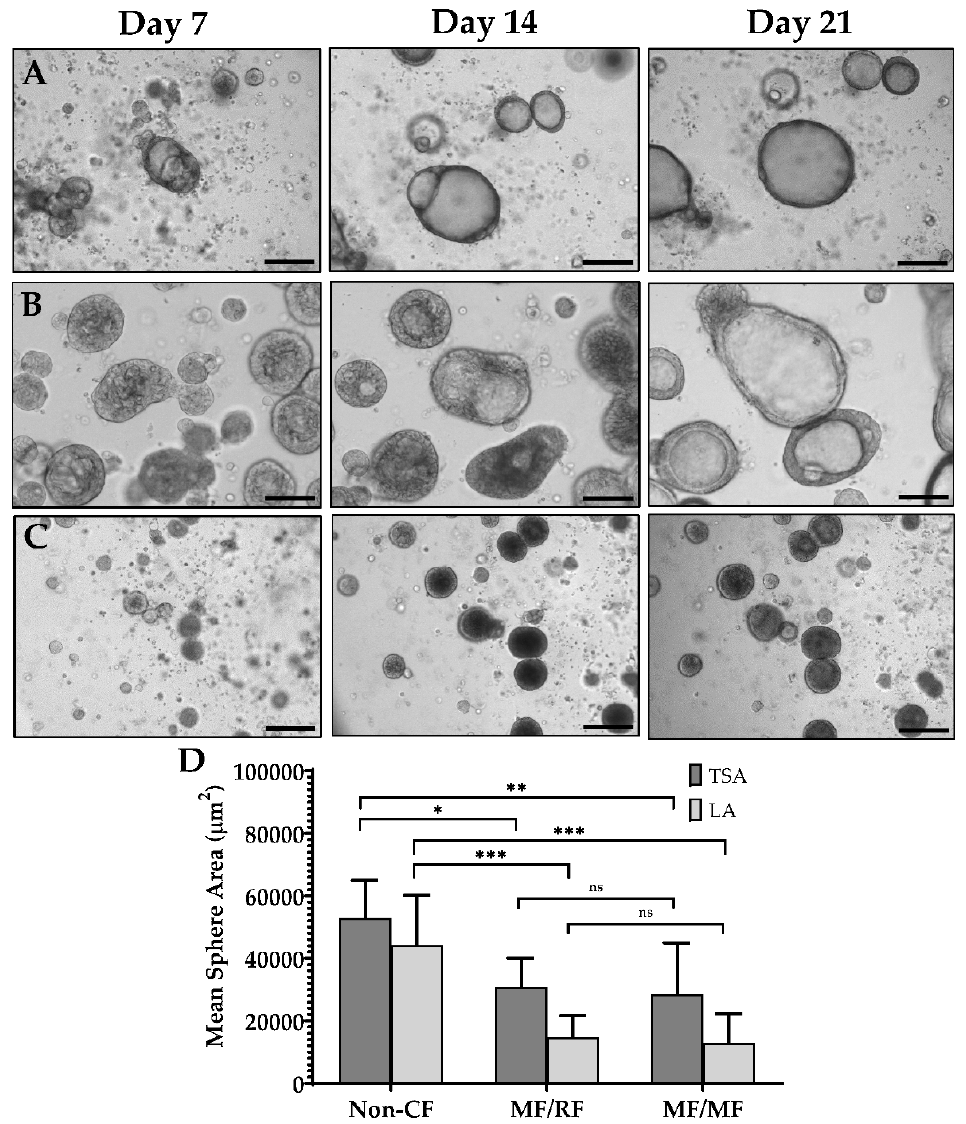
Figure 1. Nasal organoid growth characteristics. ( A – C ) Light microscopy of organoid formation over three weeks. ( A ) Non-CF ( B ) G551D / Unknown (MF / RF) ( C ) F508del / F508del (MF / MF). ( D ) The mean total surface area (TSA) and mean luminal area (LA) at 21 days of culture for non-CF (n = 6), MF / RF (n = 5), and MF / MF (n = 11) subjects’ organoids. MF = Minimal Function; RF = Residual Function. Scale = 250 µ m. * p = 0.02, ** p = 0.005, *** p = 0.0001, ns = not significant.